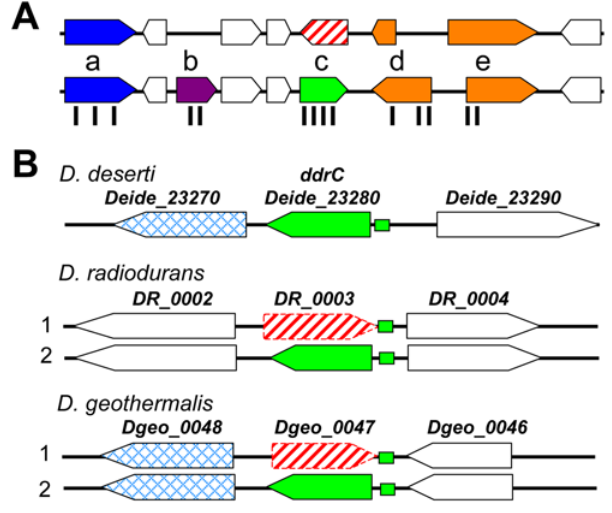
Figure 2. Gene prediction corrections revealed by proteomics and comparative genomics. (A) Schematic representation of the proteogenomic annotation strategy of D. deserti genome. First, genes were automatically predicted (upper part). Peptides detected by MS, represented by vertical black bars, were then located on the corresponding nucleic acid loci (lower part). Manual validation revealed various cases: (a) validation of predicted genes, (b) detection of non- predicted genes, (c) reversal of gene orientation, and (d, e) correction of start codons. (B) Reversal of ddrC gene orientation in D. radiodurans and D. geothermalis . Several data revealed that the orientation of DR_0003 and Dgeo_0047 (red broken arrows) has to be reversed, resulting in genes highly homologous to correctly predicted Deide_23280 (green arrows). Previous and corrected annotations are labeled 1 and 2, respectively. Green boxes represent the radiation response motif upstream of correct ddrC genes. Flanking genes Deide_23270 and Dgeo_0048 are